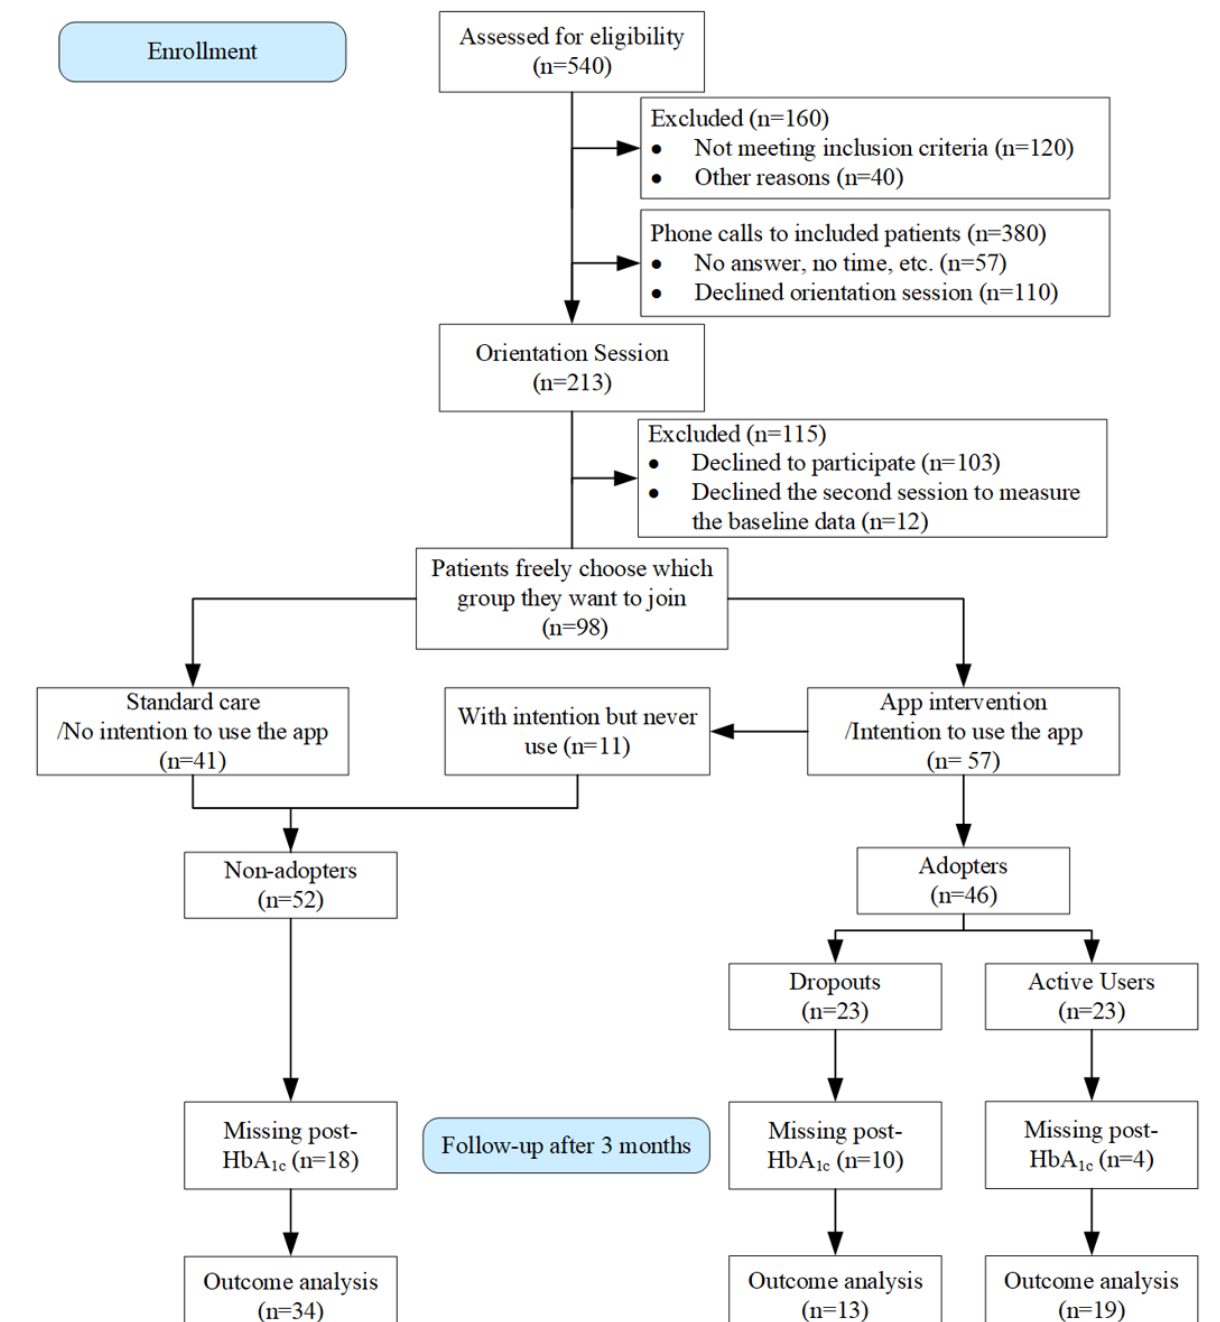
Figure 1. CONSORT flow